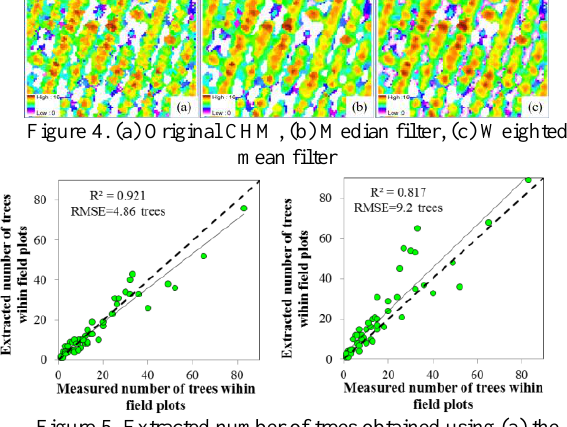
Figure 5. Extracted number of trees obtained using (a) the CHM smoothed by a weighted mean filter and (b) the CHM smoothed by a median filter